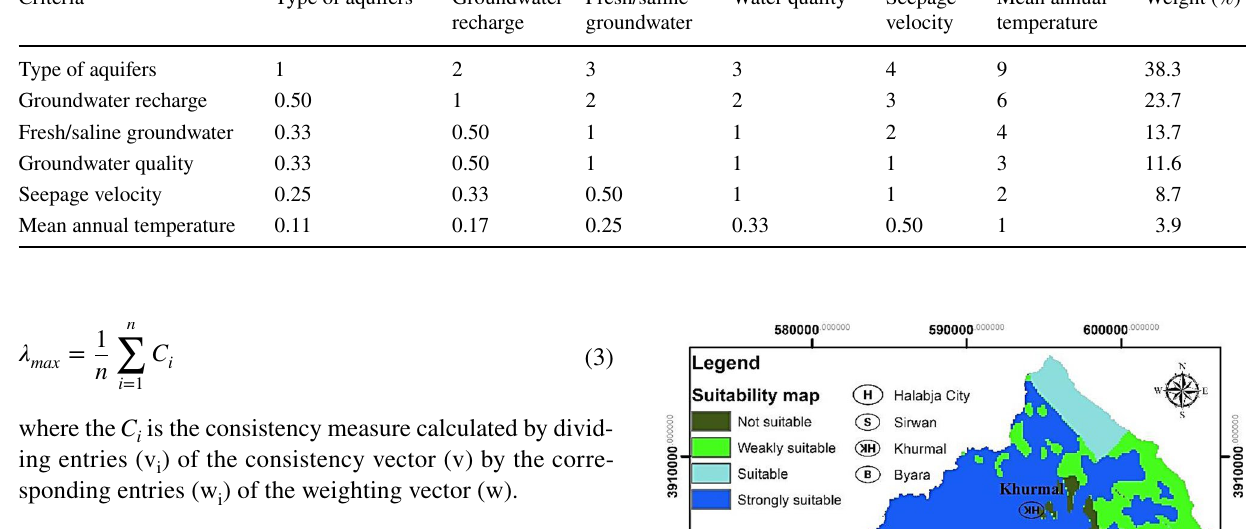
Table 3 Pairwise comparison matrix with AHP method for calculating the ATES suitability Criteria